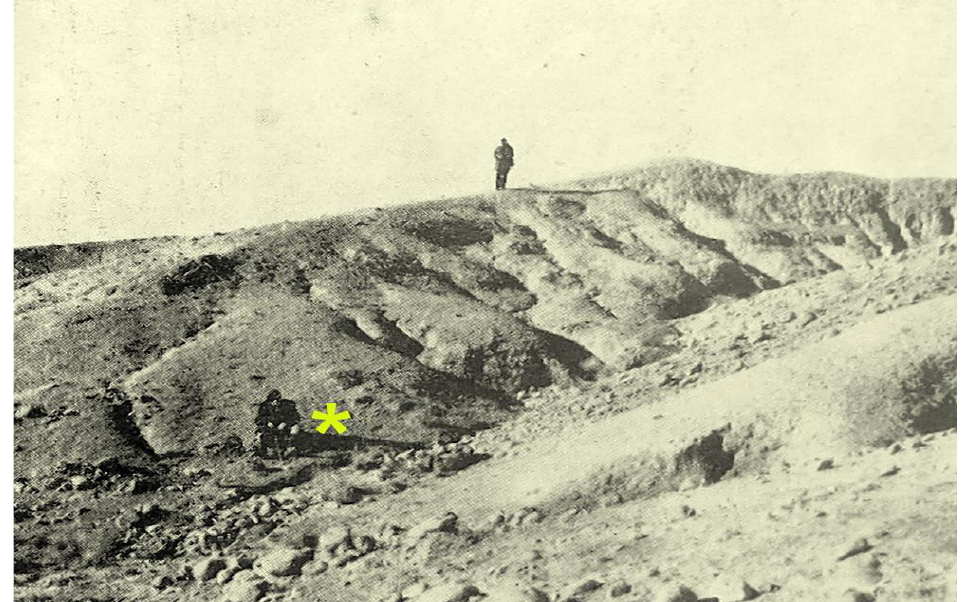
Figure 2. The Psammornis -bearing red clays on the southern flank of the Chebket Safra, SW of the city of Moulares in south-western Tunisia. The level containing remains of broken eggs preserved in situ is shown by the yellow asterisk. Photo by E.G. Gobert, modified after Chomowitch (1951). As emphasised by Choumowitch, contrary to previous Psammornis finds, the egg- shell fragments from Chebket Safra came from well-dated sediments. They were found in palaeosols containing calcareous concretions and fossil helicid gastropods, notably Leu- cochroa tissoti , considered as indicating a Pontian age. Choumowitch’s investigations showed that the eggshell fragments did not come from Quaternary pebble deposits top- ping the hills. Digging into the red clays to a depth of one metre below the surface, he found an accumulation of eggshell fragments (weighing altogether more than 11 kg) ar- ranged into small groups, each of which apparently corresponded to an egg. The whole accumulation was interpreted as a nest.